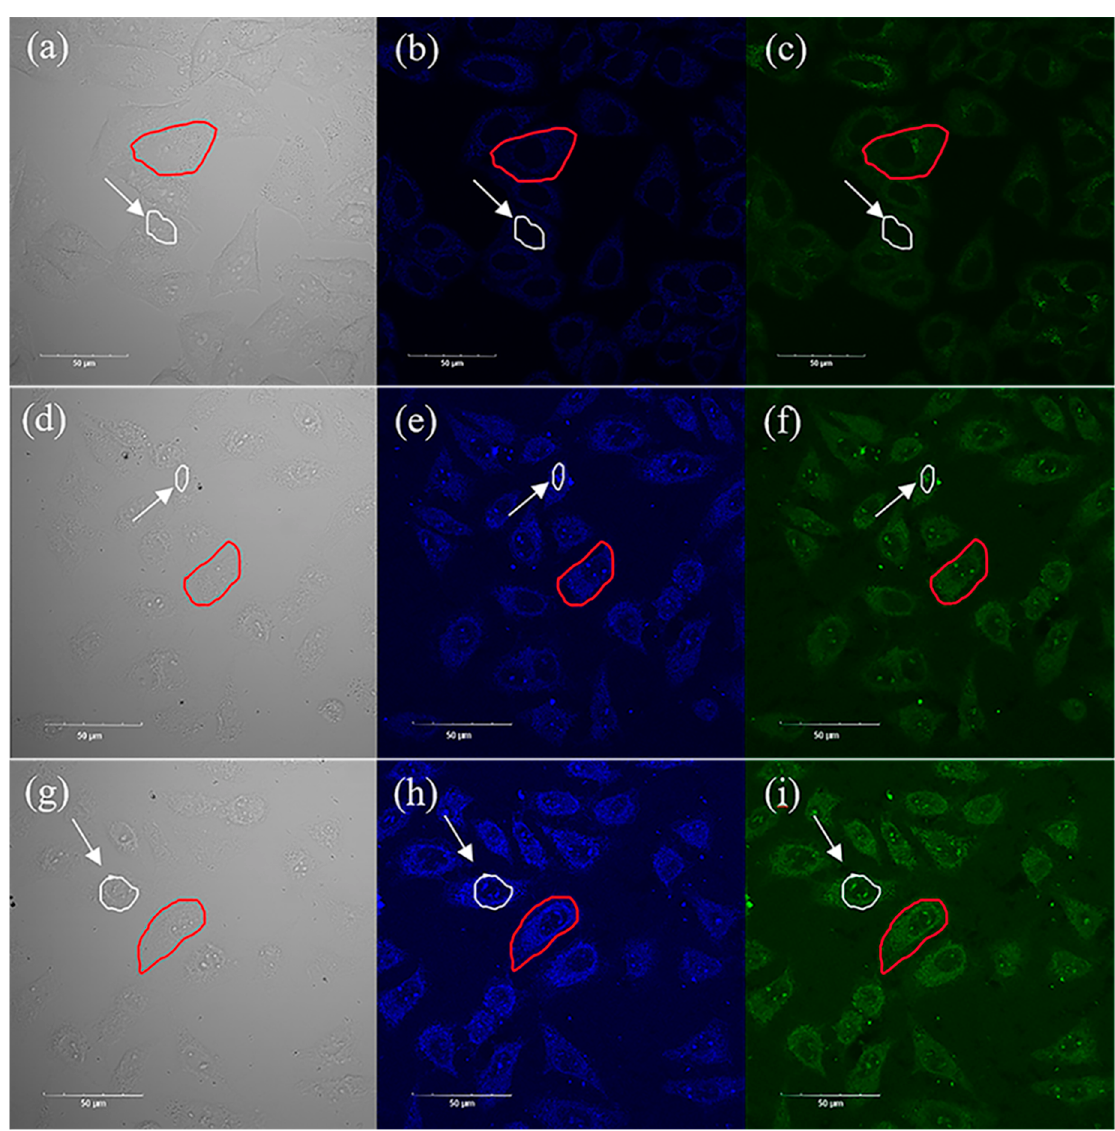
Figure 6. ( a – c ) Brightfield images and fluorescence images of HepG2 cells in the control group, where ( a ) is the brightfield image, ( b ) is the fluorescence image with the blue channel, ( c ) is the fluorescence image with the green channel. ( d – f ) Brightfield images and fluorescence imaging of HepG2 cells co-incubated with Cs 3 Bi 2 Cl 9 QDs for 24 h, where ( d ) is the brightfield image, ( e ) is the fluorescence image with the blue channel, ( f ) is the fluorescence image with the green channel. ( g – i ) Brightfield and fluorescence imaging of HepG2 cells incubated with Cs 3 Bi 2 Cl 9 : Ce 30% QDs for 24 h, where ( g ) is the brightfield image, ( h ) is the fluorescence image with the blue channel, and ( i ) is the fluorescence image with the green channel. The red circles in the figure show the target cells to be measured, the white circles and the arrows show the target cell nuclei, and the scale of the icon is 50 µ